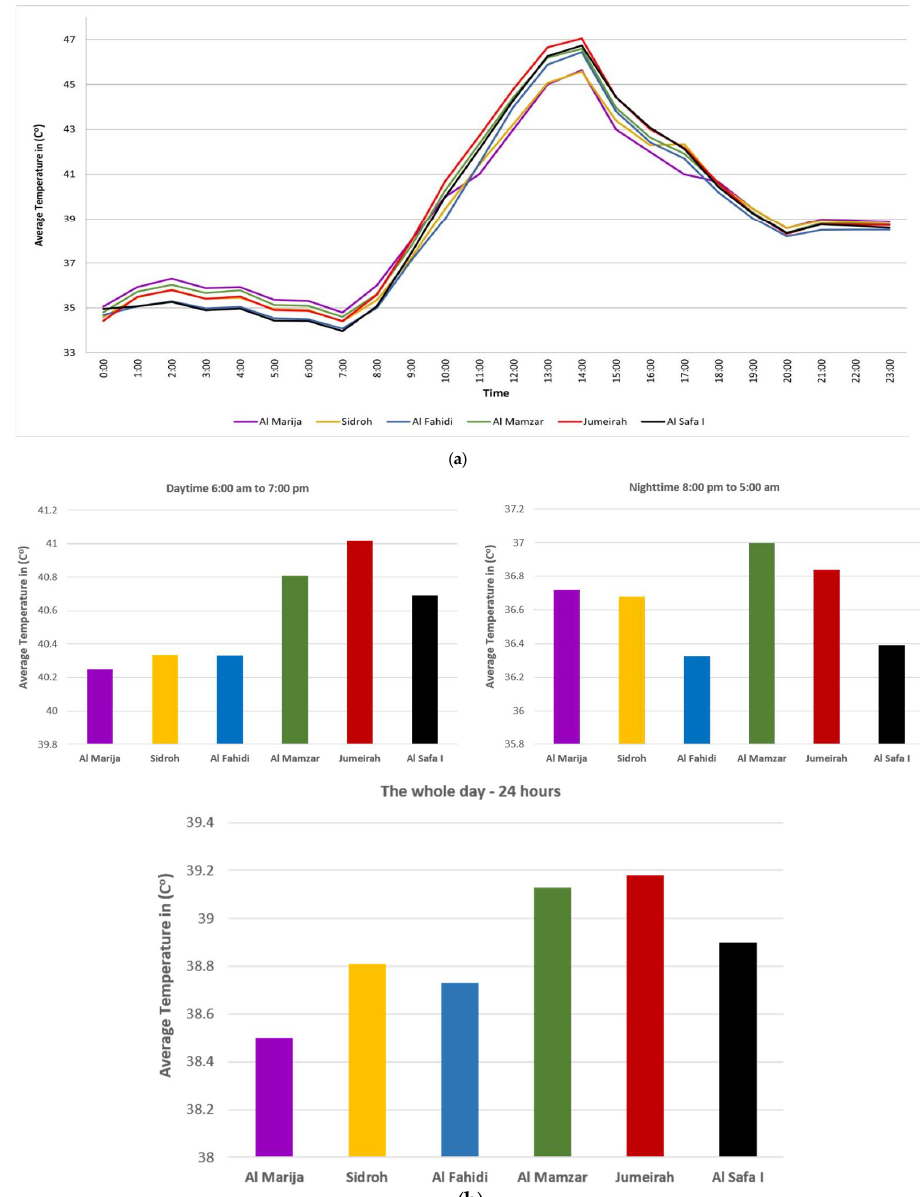
Figure 8. ( a ) Hourly variations of air temperature (°C) for Al Marija, Sidroh, Al Fahidi, Al Mamzar, Jumeirah, and Al Safa I in August. ( b ) Average air temperature (°C) for daytime, nighttime, and the whole 24 h in August.